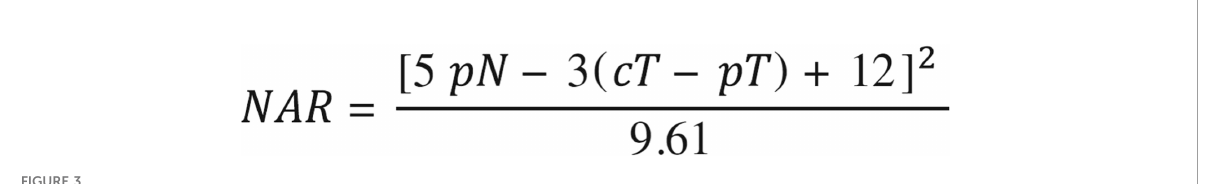
FIGURE 3 Calculation formula of the neoadjuvant rectal (NAR) score. NAR, pathologic nodal stage, clinical tumor stage, and pathologic tumor